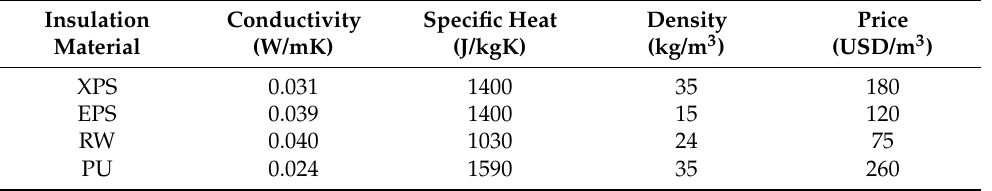
Table 2. Thermal properties and costs of insulation materials [15,37]. Insulation Material